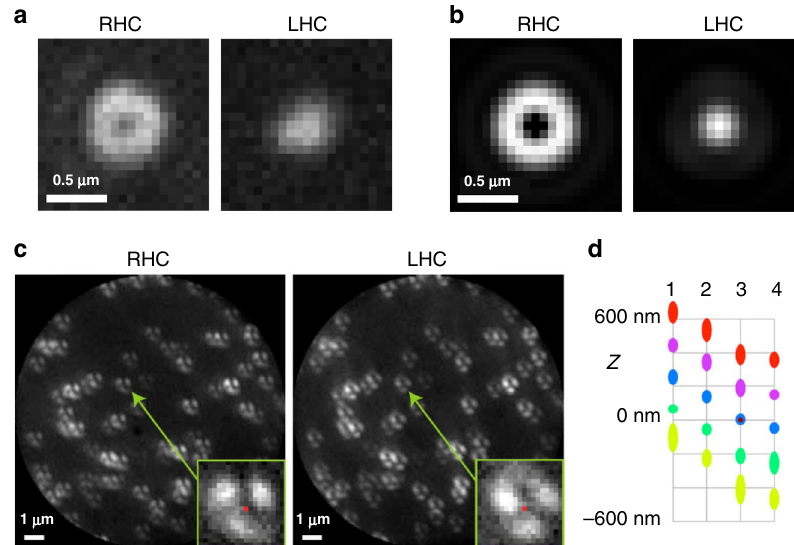
Fig. 5 Experimental PSFs obtained from nanobeads under circular polarization and simulated z -oriented dipole. a Measured and b simulated images for two nanobeads followed by a circular polarizer. c Image pair for a group of nanobeads with a S waveplate inserted at the pupil plane for simulating emitters oriented in the z direction. For these images, the integration time is typically 1 s (camera gain 300). The insets show zooms of the PSFs of a particular bead, where the red dot indicates the retrieved ( x , y ) coordinates. d Estimation of z (average — center of the ellipse, and standard deviation — height of the ellipse) for the fi ve defocused measurements of the four sets of measurements. The brown dot at the central position for set 3 indicates that it corresponds to the images shown in part ( c ). All retrieved data are depicted in Supplementary Movie 2, including standard deviations for each